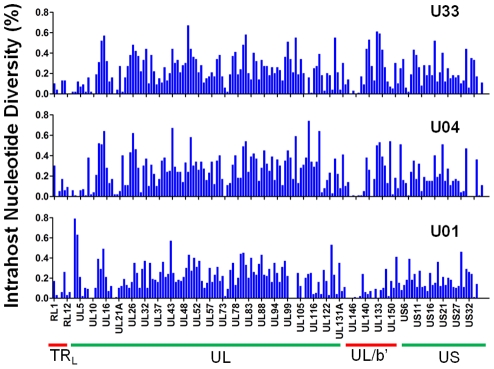
Intrahost nucleotide diversity was detected in most ORFs of the HCMV genome.Intrahost nucleotide diversity (π) was plotted for each ORF of the HCMV genome based on high throughput sequence data of clinical samples from three patients: U01, U04, and U33. The ORFs are listed in layout of the standard HCMV genome from 5′ to 3′. See Table S3 for a tabular representation of these data. Due to space constraints, not all ORFs are named on the plot. The major divisions of the HCMV genome are shown below the graph.